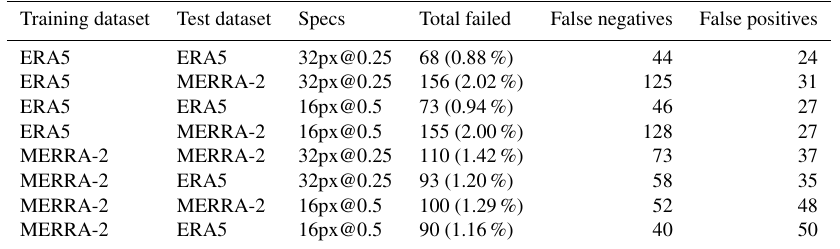
Table A6. Statistics of failed predictions by combinations of training/testing datasets.